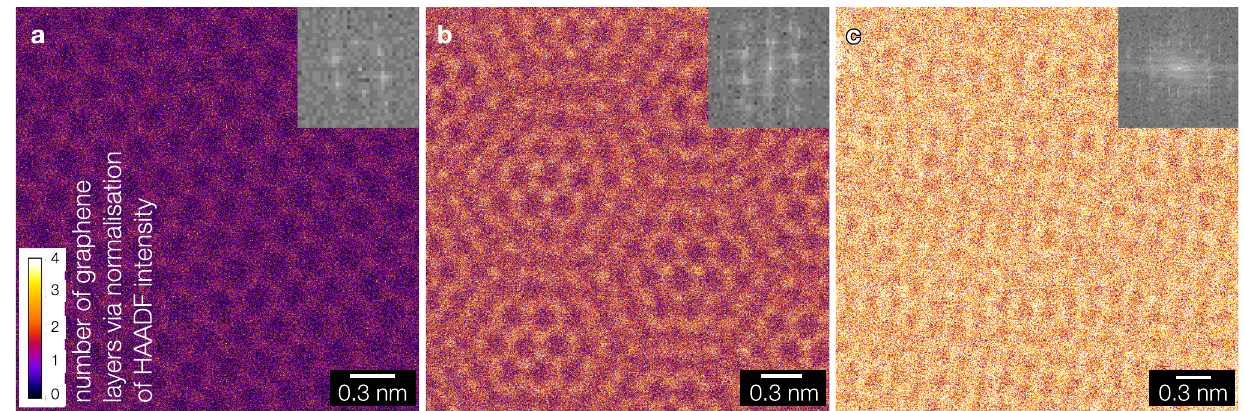
Fig. 3 Electron microscopy of single-, bi- and trilayer graphene. Intensities in atomic resolution high-angle annular dark- fi eld (HAADF) scanning transmission electron microscopy (STEM) images, as well as their corresponding fast Fourier transforms (inset) clearly con fi rm single-layer (SLG, panel a ), bilayer (BLG, panel b ) and trilayer (TLG, panel c ) nature of Graphenea samples. Importantly, average HAADF intensity linearly scales with increasing graphene layer number. The relative layer orientation of individual layers in BLG and TLG is random (evidenced by the Moire patterns in the HAADF images and the multiple sets of six-fold spots in the fast Fourier transform). This is due to multiple sequential single-layer transfers to build up the BLG and TLG rather than multilayer growth.